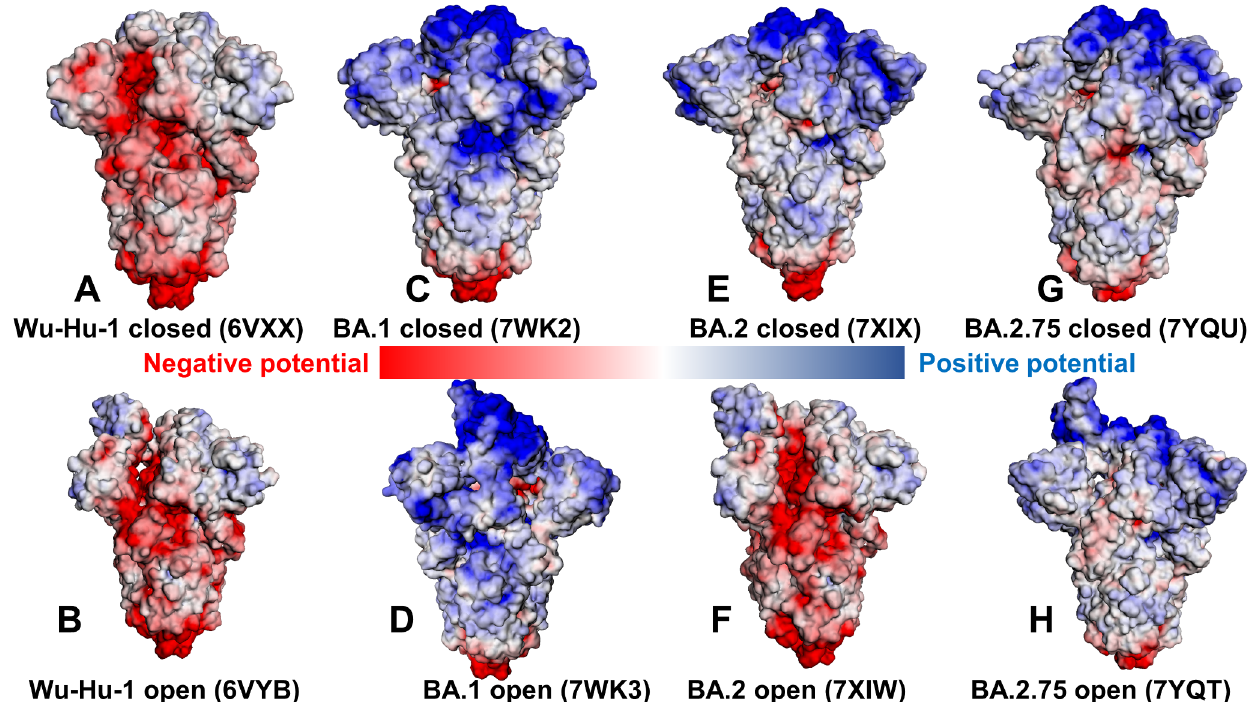
Figure 5. The distribution of the electrostatic potentials calculated with the APBS method [84,85] on the molecular surface of trimeric S proteins of Wuhan strain (Wu-Hu-1) closed state (pdb id 6VXX) ( A ). S-Wu-Hu-1 trimer in the open state (pdb id 6VYB) ( B ). S-Omicron BA.1 closed trimer (pdb id 7WK2) ( C ). S-Omicron BA.1 open 1-up trimer (pdb id 7WK3) ( D ). S-Omicron BA.2 closed trimer (pdb id 7XIX) ( E ). S-Omicron BA.2 open trimer (pdb id 7XIW) ( F ). S-Omicron BA.2.75 closed trimer (pdb id 7YQU) ( G ). S-Omicron BA.2.75 open trimer (pdb id 7YQT) ( H ). The color scale of the electrostatic potential surface is in units of kT/e at T = 37 °C. Electro-positively and electronegatively charged areas are colored in blue and red, respectively. Neutral residues are white.